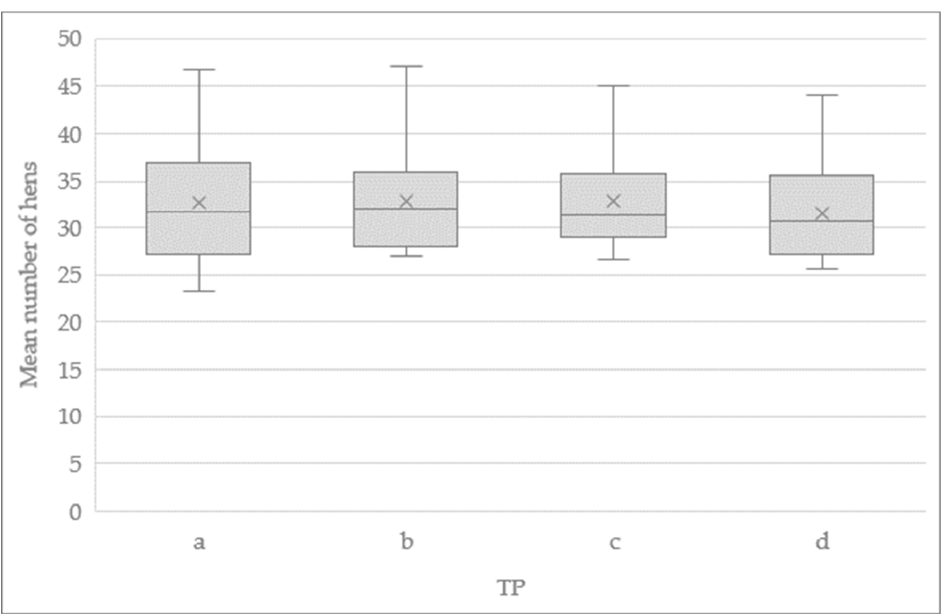
Figure 5. Mean number of hens in the observation areas beneath the device (ScA 1 and ScA 3) during the examined times (TP a–d) of maize supply for birds ranging in age from 30 to 58 weeks (TP: F = 0.23; p = 0.88). Boxplots indicate the data range, median, lower, and upper quartiles, and mean value.